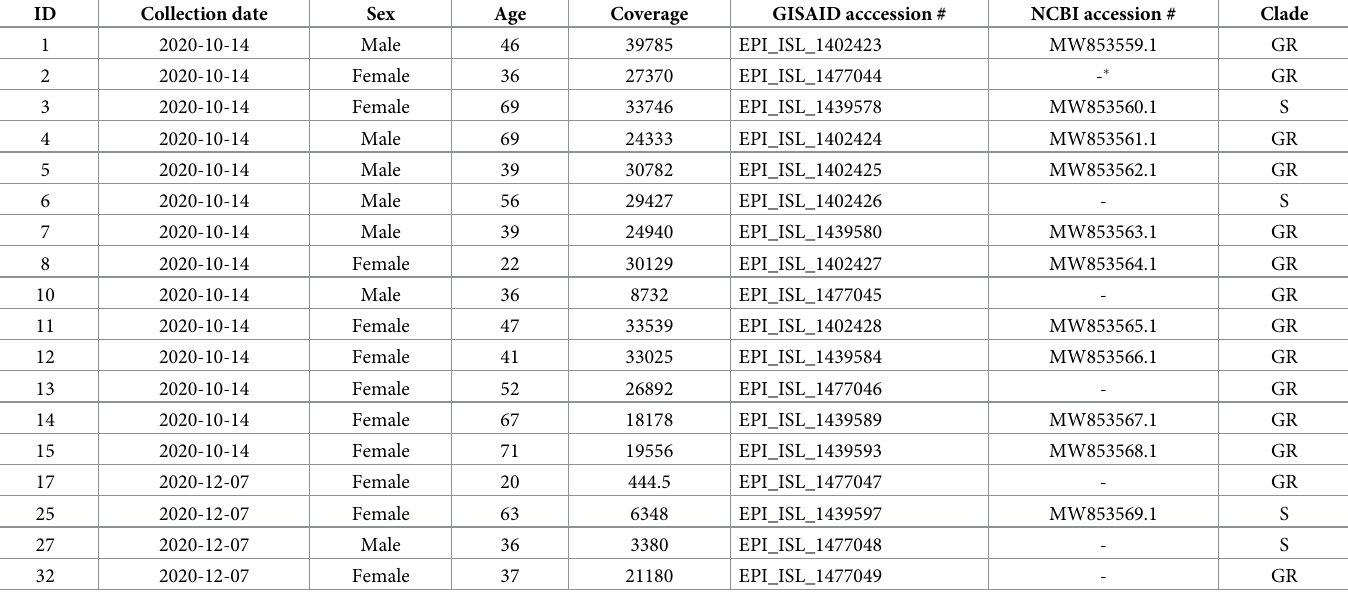
Table 1. Summary data for the COVID-19 samples used in this